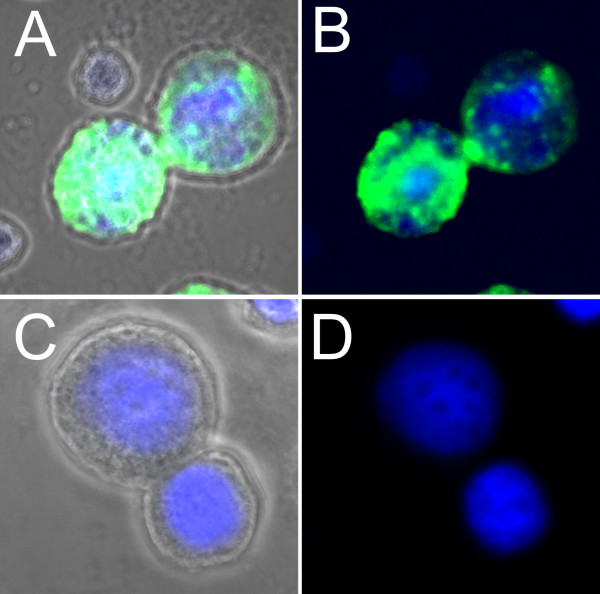
Confocal imaging of recombinant baculovirus infected Sf9 cell (A and B) and uninfected Sf9 cell (C and D). DAPI was used to stain cell nuclei and monoclonal antibody specific to HA1 of avian influenza H5 was used to localize rHA1 in recombinant baculovirus infected cells and uninfected cells.